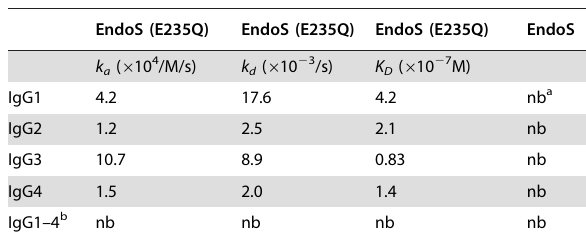
Table 1. Kinetic constants of EndoS binding to